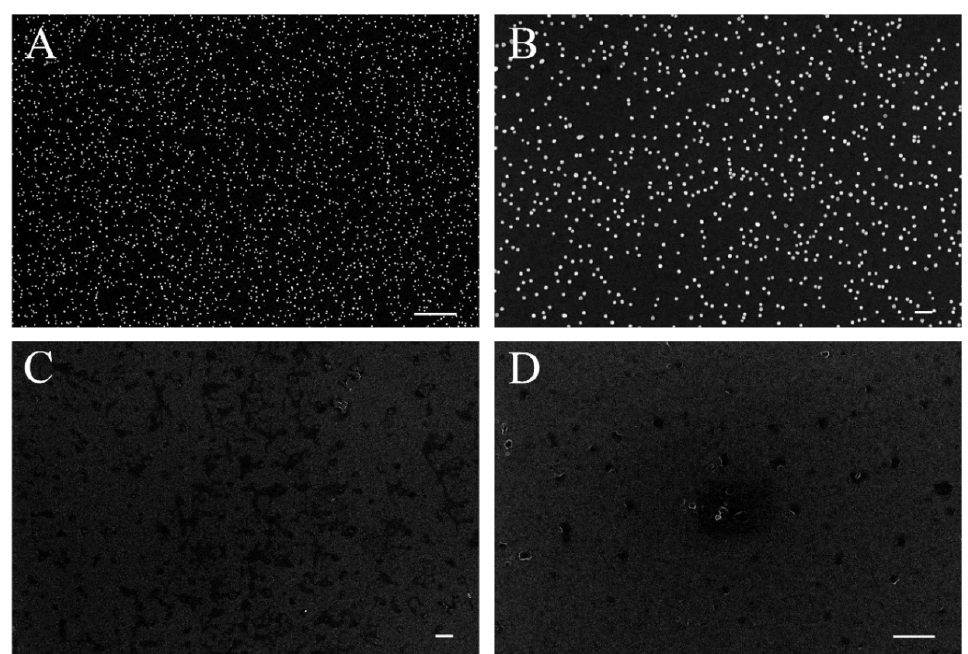
Figure 4. Comparison of presence of AuNP on the surface of sample chip A1 and negative control chip C1: ( A ) AuNP distribution on chip A1 under 10,000x magnification, scale bar length is 1 μ m; ( B ) AuNP distribution on chip A1 under 20,000x magnification, scale bar length is 200 nm; ( C ) AuNP distribution on chip C1 under 10,000x magnification, scale bar length is 1 µ m; ( D ) AuNP distribution on chip C1 under 20,000x magnification, scale bar length is 200 nm.